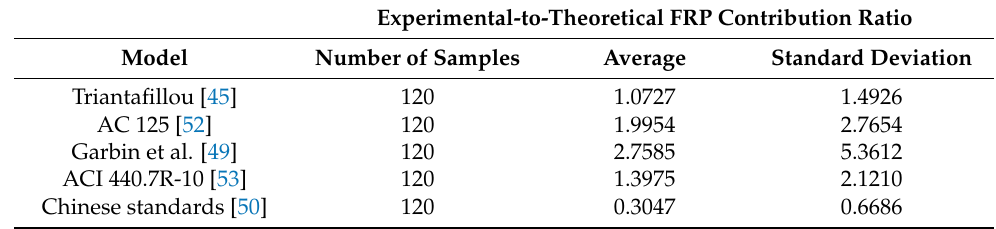
Table 3. Average experimental-to-theoretical FRP contribution ratios for the analyzed